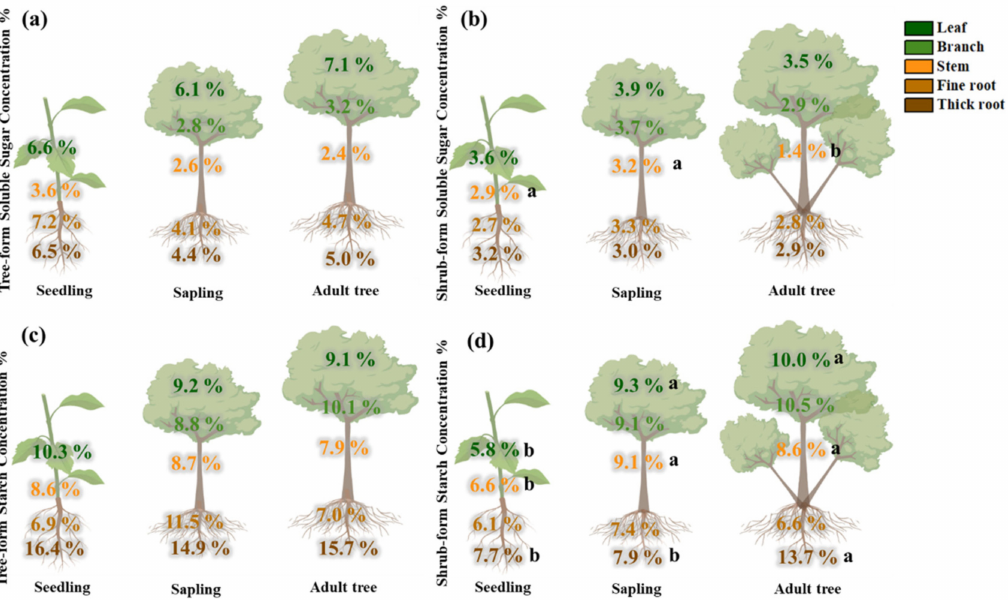
Figure 3. Effects of the interaction between life stages and organs on NSC concentration. ( a ), Soluble sugar concentration for tree form. ( b ), Soluble sugar concentration for shrub form. ( c ), Starch concentration for tree form. ( d ), Starch concentration for shrub form. Different lowercase letters indicate significant differences between life stages in the same organ ( p < 0.05).